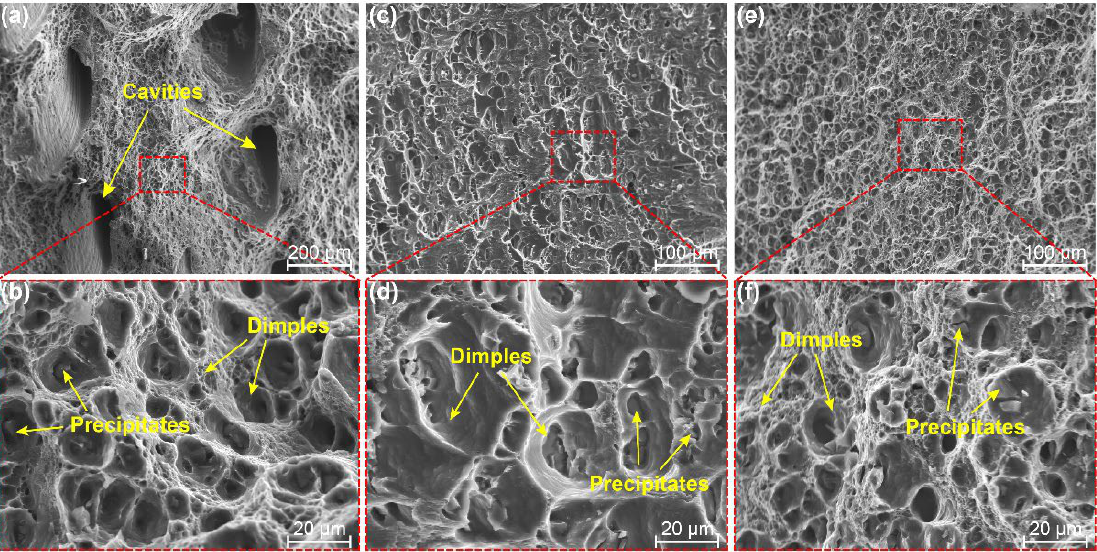
Figure 18. Fracture morphologies at the bottom joints ( a , b ) Pin-1-400-200, ( c , d ) Pin-2-400-200, and ( e , f ) Pin-2-400-400.